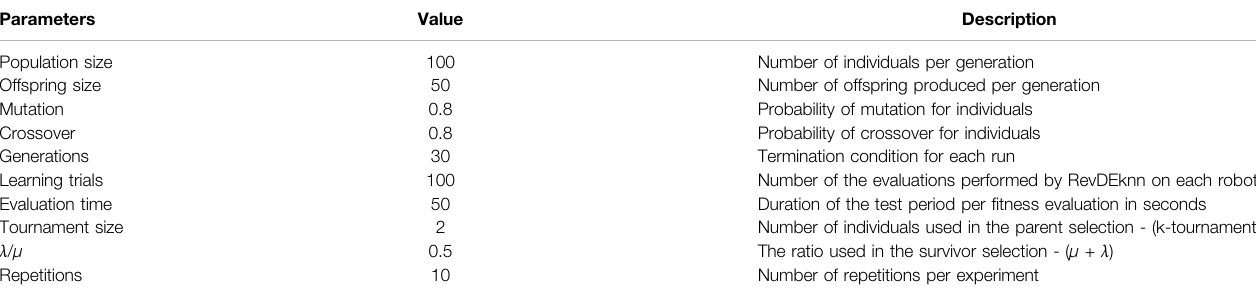
TABLE 2 | Main experiment parameters.